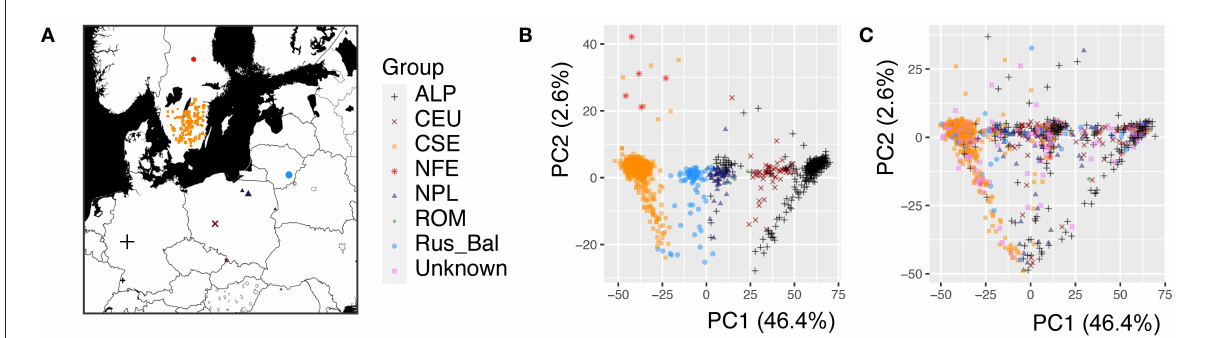
FIGURE1 The geographic origin and population structure of the Picea abies trees used for the genome-wide association study. (A) Geographic distribution of the P. abies mother trees (1,080 mother trees genotyped), and the color and shape of the dots represent the genetic cluster indicated in the PCA analysis, (B) Population structure of the 1,080 mother trees visualized by the first two principal components (PCs), and (C) Population structure of the 1,303 progenies. A total of 1,080 mother trees cluster into seven genetic groups (Chen et al., 2021), but the genetic group is unknown for 223 mother trees. The PCA analysis was performed by combining the parental and progeny datasets. The different genetic clusters were marked (Carpathian including Romania, forest green, ROM; Alpine, black, ALP; Central Europe, dark red, CEU; Northern Poland, midnight blue, NPL; Russia-Baltic, dodgerblue, Rus-Bal; central and southern Sweden, dark orange, CSE; Fennoscandia, red, NFE; Unknown in violet represents unknown